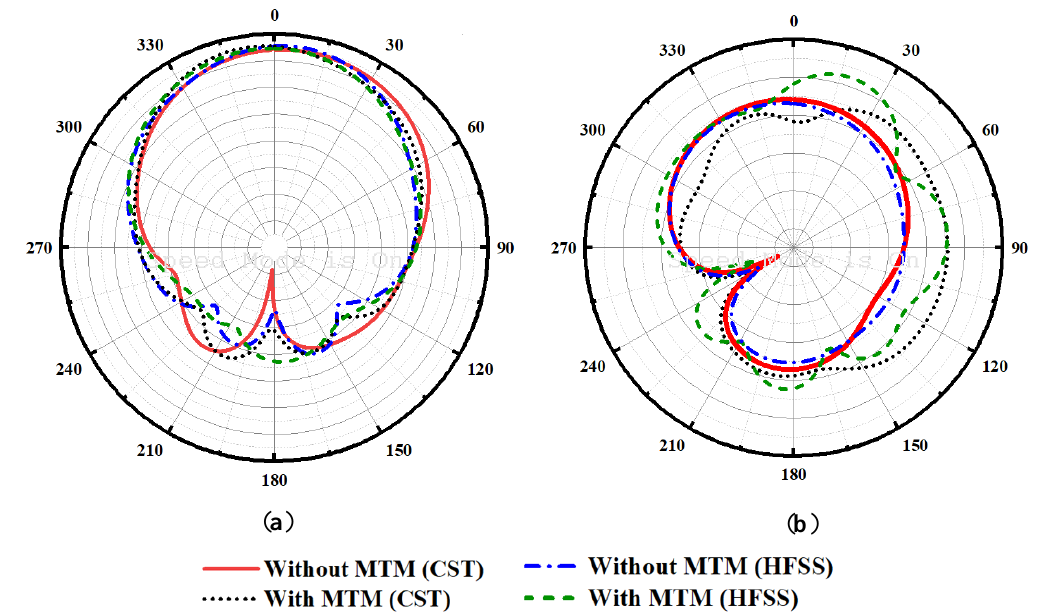
Figure 21. ( a ) Envelop correlation coefficient (ECC), ( b ) Diversity gain (DG), and ( c ) channel capac- ity loss (CCL) of Ant. C with and without the presence of the MTM unit cell .